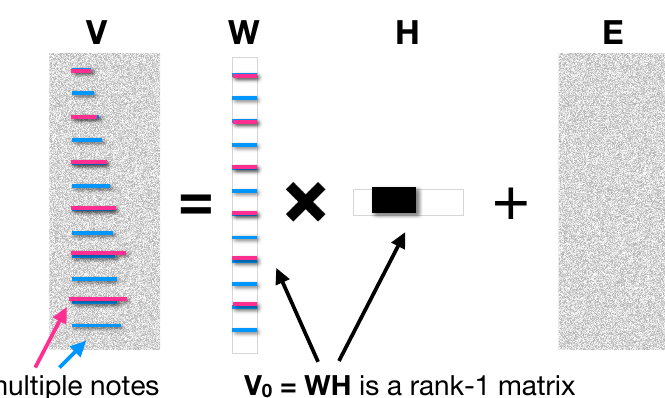
Figure 8. Illustrative diagram of the NMF model for the case in which a chord is played at the first